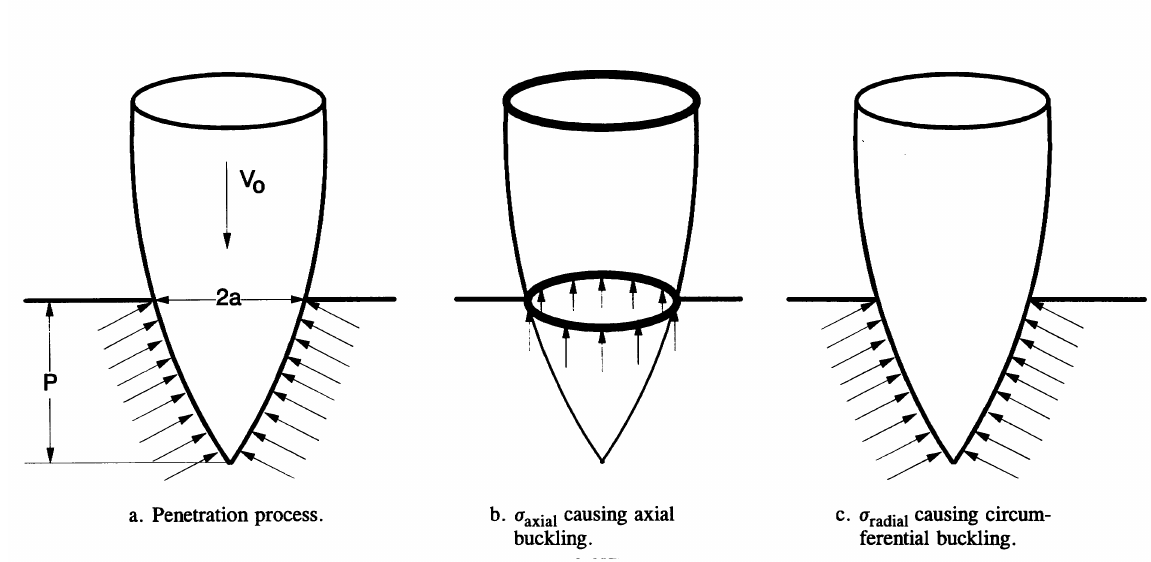
FIGURE 5 Penetration process, axial, and radial stresses inducing buckling: (a) penetration process; (b) (Taxi.l causing axial buckling; (c) (Tradial causing circumferential